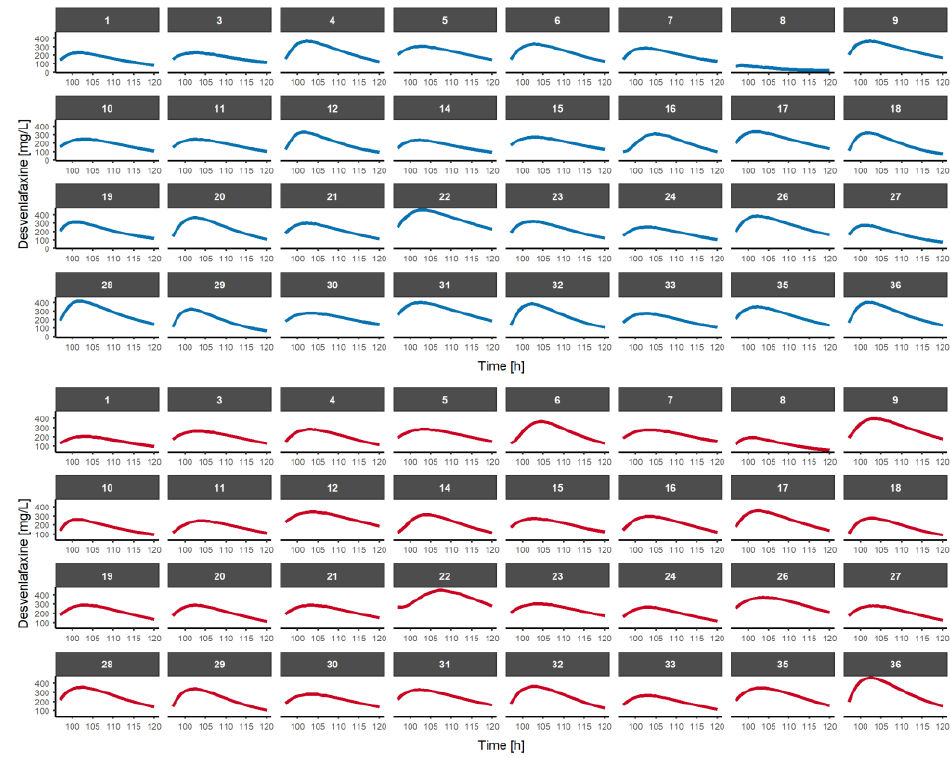
Figure 4. Individual pharmacokinetic time-course profiles at steady-state conditions of desvenlafaxine in healthy volunteers receiving 100 mg every 24 h. Blue and red lines represent desvenlafaxine simulated concentrations from Reference and Test formulations, respectively.